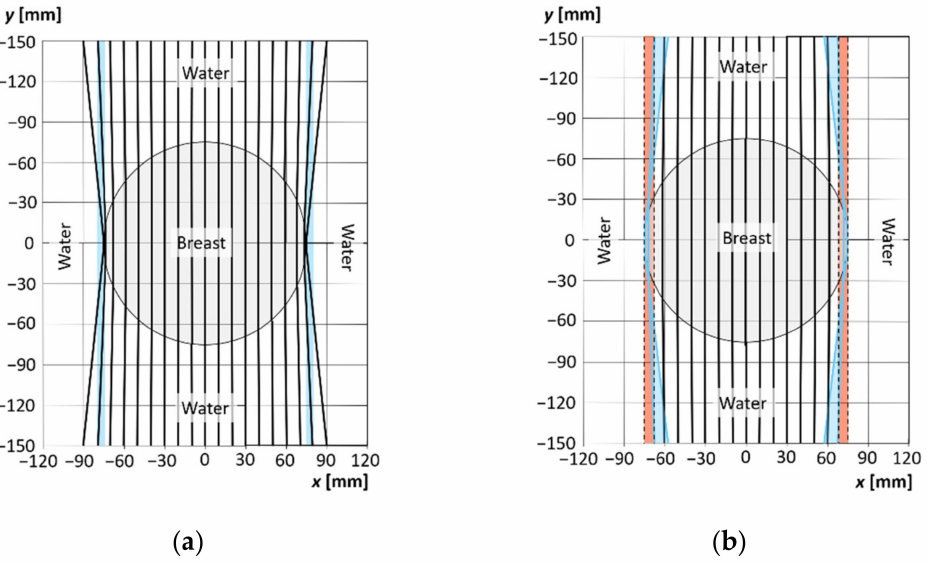
Figure 2. Simulation of the refraction effect of ultrasound beam rays along the path from the transmitter to the receiver placed on an axis at a distance of 300 mm opposite each other and moved with a constant step (10 mm) along the circular cross-section of a cylinder (breast) immersed in water: ( a ) n = 0.991; ( b ) n =